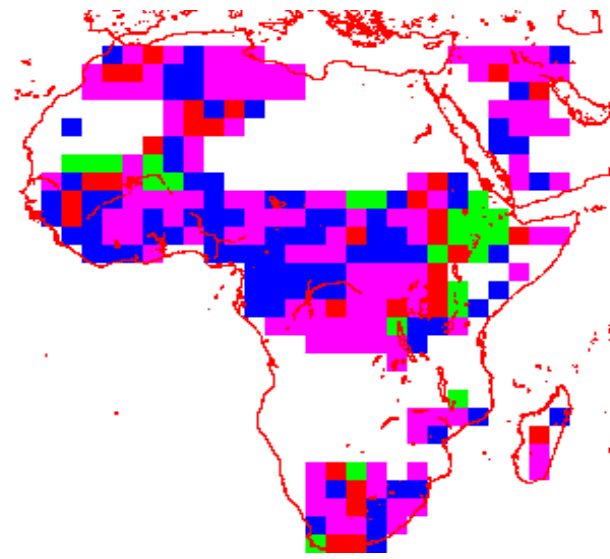
Fig. 7b. Pre-onset period: Spatial repartition of the four classes Figure 7.b. Pre-onset period: Spatial repartition of the four classes computed by non supervised computed by non supervised classification. Same color code as in classification. Same color code as in Fig. 7.a. Fig.